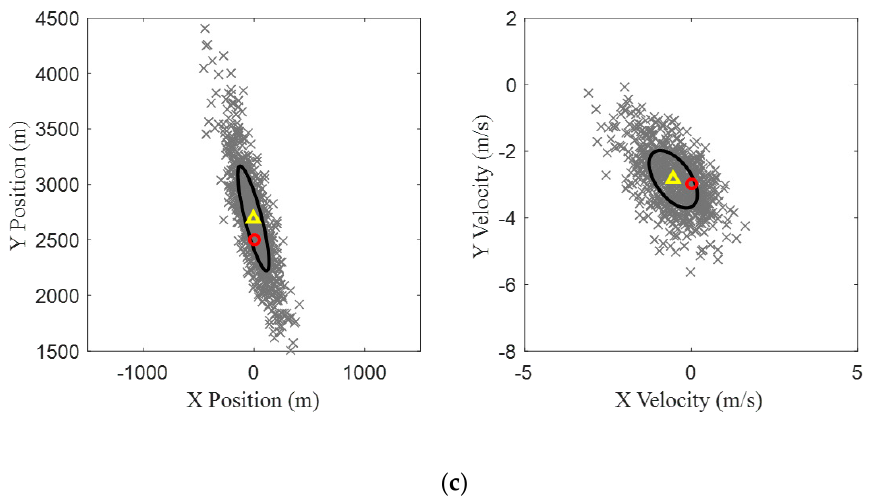
Figure 8. The distribution of initial states estimated using TMA for 1000 random runs for standard deviations of zero mean Gaussian measurement errors of ( a ) 0.2, ( b ) 0.4, and ( c ) 0.6 ◦ . The true initial state vector of the target is [ 0 m, 2500 m, 0 m/s, − 3 m/s ] . The left column shows the initial target position estimates, and the right shows target velocity estimates. The true initial state vector of the target and the mean of estimated state vectors are indicated by red circles and yellow triangles, respectively. The regions within one standard deviation of the mean are indicated by black ellipses. , , , Table 2. The means and variances of the estimated initial state vector [ ] for three values of standard deviation of measurement error. 𝑝𝑝̂ 𝑦𝑦𝑚𝑚 (1) 𝑣𝑣� 𝑥𝑥𝑚𝑚 (1) 𝑝𝑝̂ 𝑥𝑥𝑚𝑚 (1) 𝑣𝑣� 𝑦𝑦𝑚𝑚 (1)